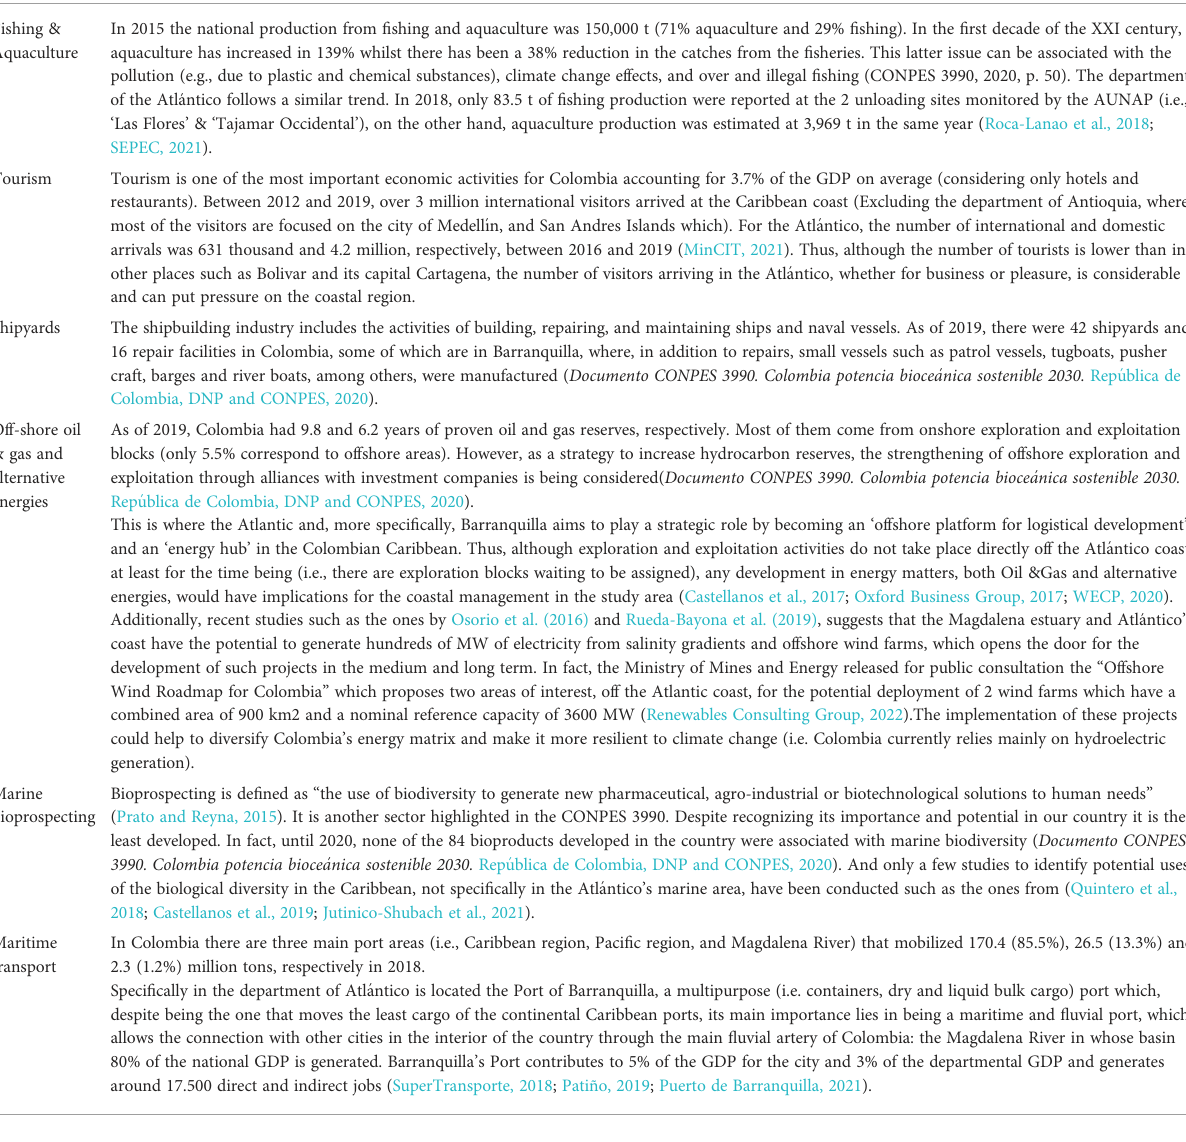
TABLE 5 Main activities of the blue economy in the Atla ́ ntico